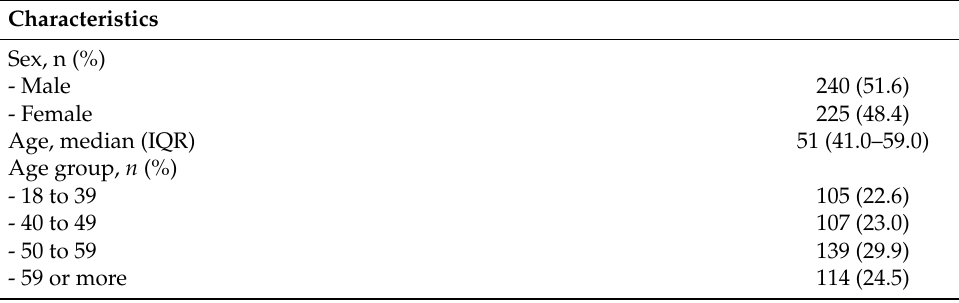
Table 1. Characteristics of the healthcare workers participating to the survey ( n =